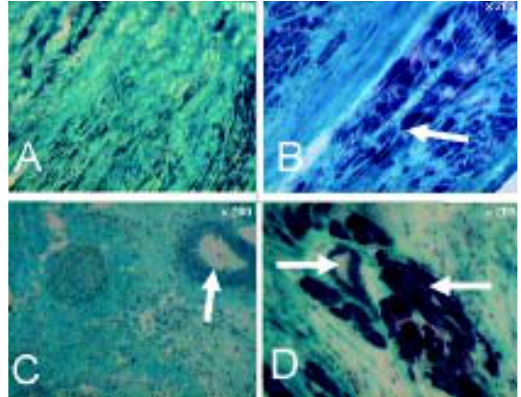
Fig. 2 - A-Microfotografia da cicatriz, após 1 mês de IM. B- Microfotografia do estudo histopatólogico, do grupo ME, identificando pela seta o tecido muscular transplantado. C- Microfotografia do estudo histopatólogico do grupo CTM, identificado pela seta a neoangiogênese. D-Microfotografia do estudo histopatólogico do grupo Co-cultura, identificados pelas setas a angiogênese e a miogênese. Os cortes histológicos foram corados com Tricrômio de Gomori e os aumentos estão identificados em cada